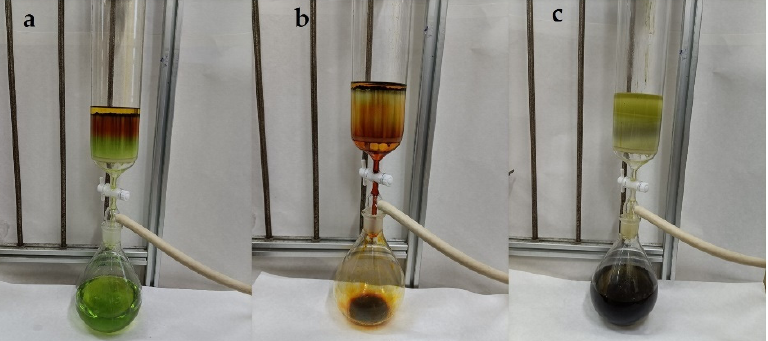
Figure 1. Fractionation process of the crude extract from Sargassum horneri with octadecylsilyl (ODS) column chromatography. ( a ) Addition of ethanol:water (7:3, v / v ), ( b ) addition of ethanol:water (9:1, v / v ), ( c ) addition of absolute ethanol.